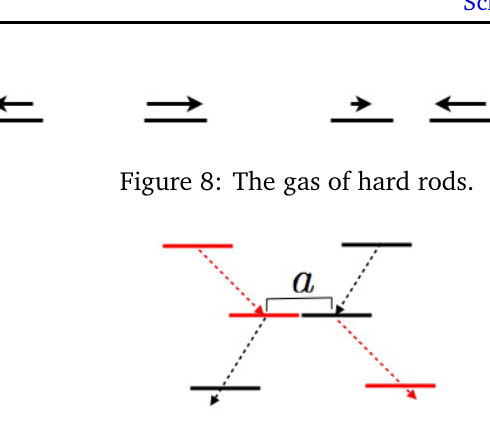
Figure 9: Upon collision, velocities are exchanged. We can think of a